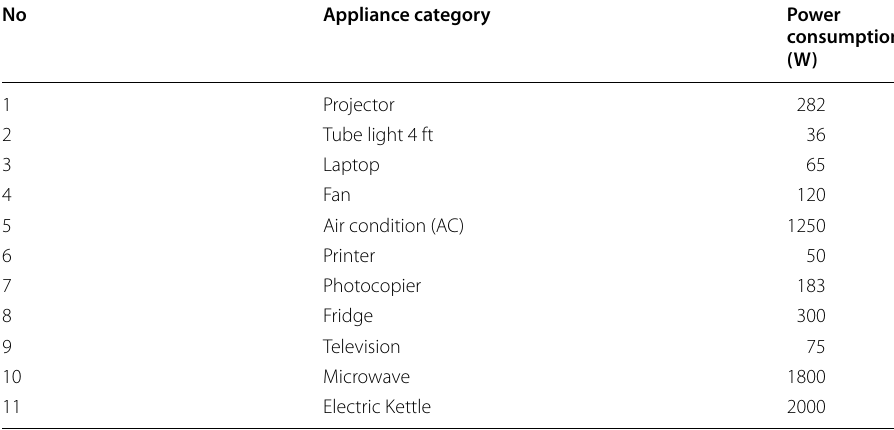
Table 1 Power consumption for the most commonly used appliance in HLIs No Appliance category Power